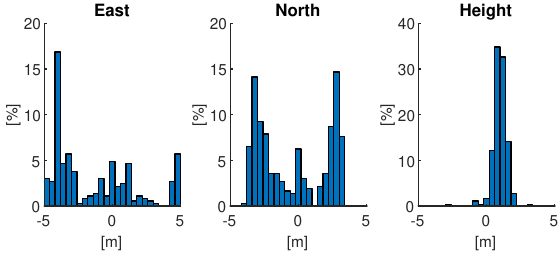
Figure 2. Histograms of the differences between the image positions from the UAV telemetry and those estimated in the reference solution.